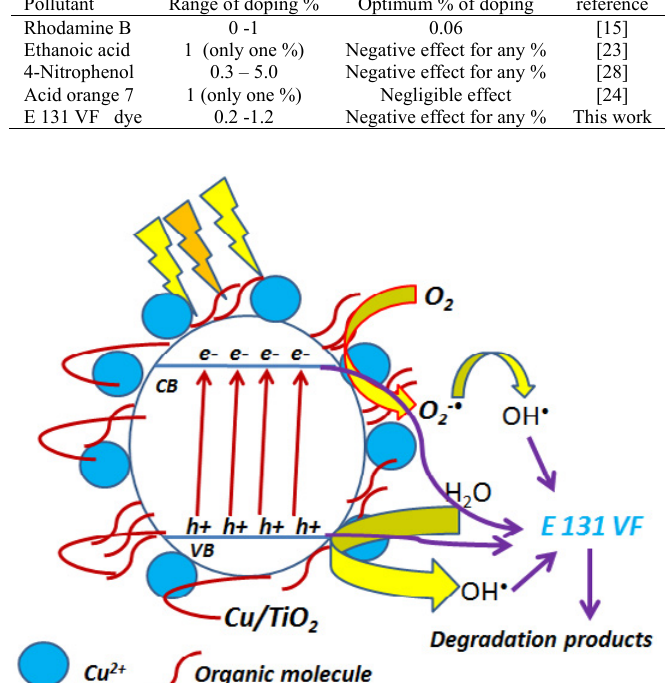
Fig.10. Our proposed mechanism for photocatalytic degradation of E 131 VF dye over Cu/TiO